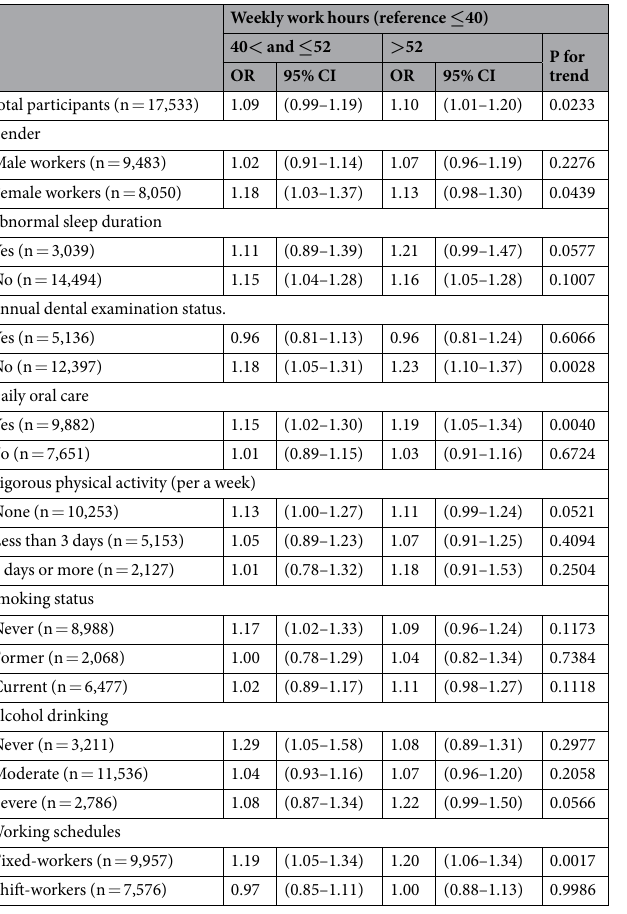
Table 4. Odds Ratio (OR) and 95% confidence interval (CI) for periodontitis by long working hours category with subgroup analysis. All models were adjusted for age, sex, socioeconomic status (educational level and household income level), occupational classification, job position, health behaviour (alcohol drinking, smoking, physical activity level, and daily sleep duration), chronic disorders (metabolic syndrome), and dental care (daily dental care and annually dental examination) except a stratified variable,